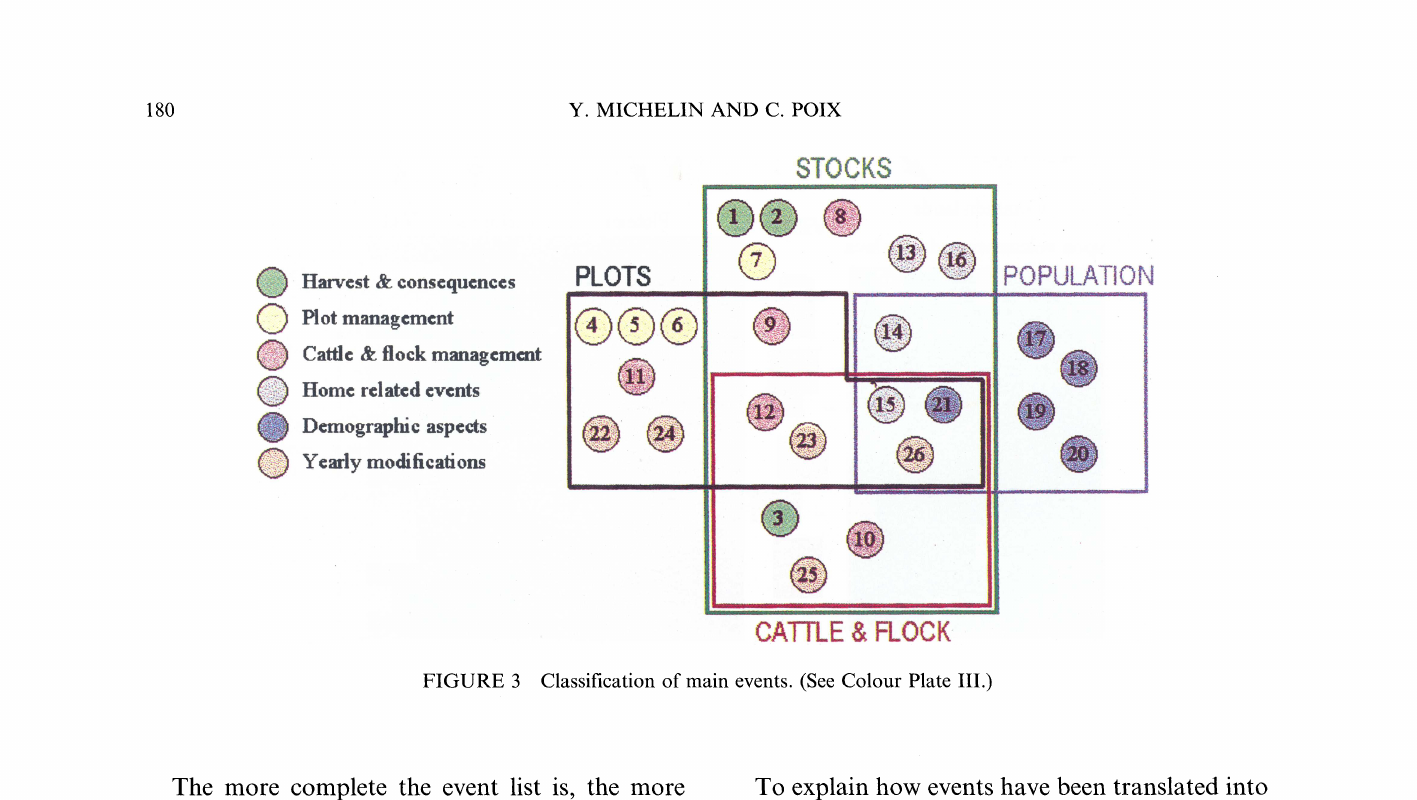
FIGURE 3 Classification of main events. (See Colour Plate